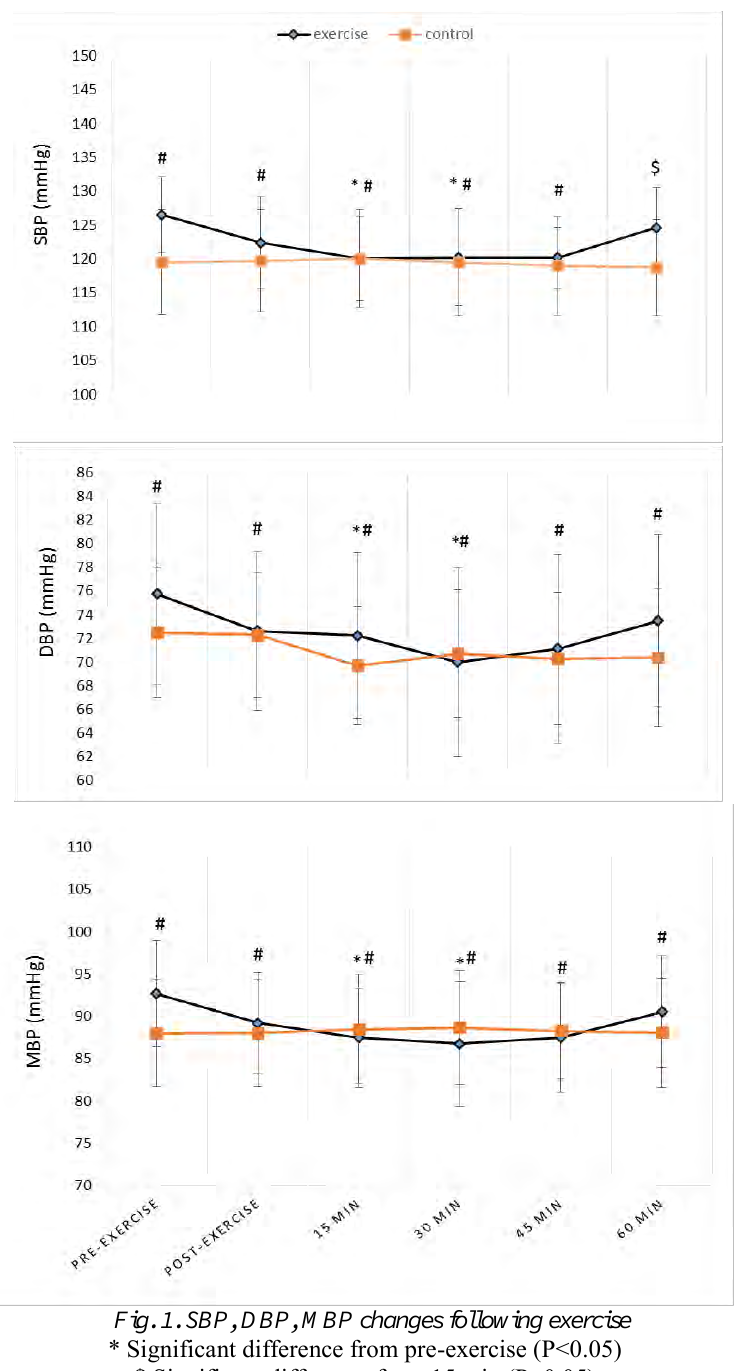
Fig. 1. SBP, DBP, MBP changes following exercise * Significant difference from pre-exercise (P<0.05) $ Significant difference from 15 min (P<0.05) # Significant difference between the two group